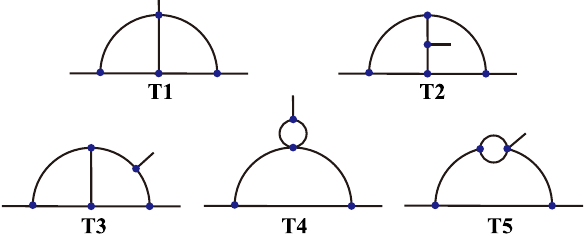
Fig. 2 Finite two-loop 1PI topologies with three- and four-point ver- tices and three external legs, which are all associated with the two-loop realizations of the operator L 4 [89]